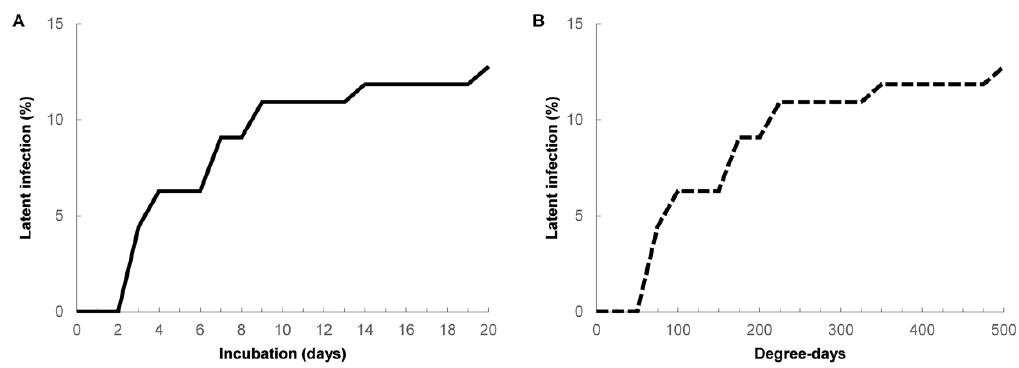
Figure 1. Latent infection incidence on nectarines incubated at 25 ◦ C for 20 d ( A ) or 500 DD (degree-days) ( B ) for overall cultivars in Treatment 1 (without any refrigeration period). Table 3. Degree-days above 0 ◦ C (DD) for each postharvest handling treatment and incubation